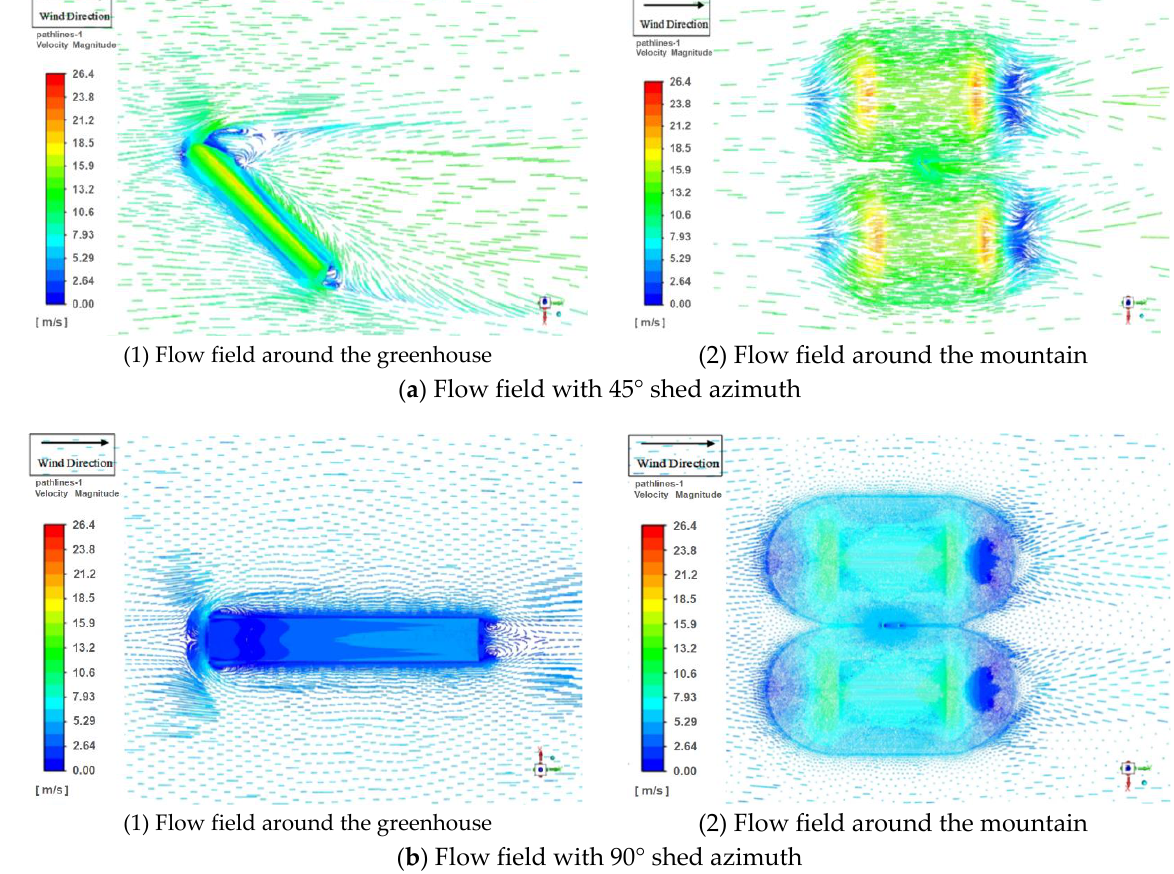
Figure 12. Flow field distribution on the surface of the shed.